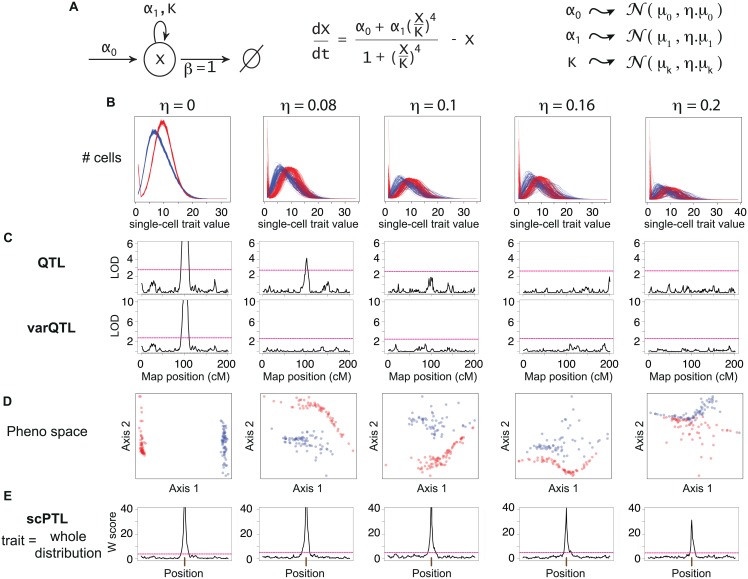
Test on simulations.A) A model of gene expression with positive feedback was used to simulate data (see methods). For each of ~130 distinct individuals, parameters α0, α1 and K were drawn from Gaussian distributions and then used to generate independent values of X in 10,000 cells of each individual. Mean values μ0, μ1 and μK depended on the genotype of individuals at a locus located in the middle of a 200cM genetic map. Other sources of inter-individual variability were modeled by the extrinsic noise strength η. B) Distributions obtained (one per individual) at various values of η. Color: genotype at the locus controlling μ0, μ1 and μK. C) QTL scans. For each individual, the mean (upper panels) or the variance (lower panels) of X were considered as quantitative traits and the map was scanned using interval mapping. Red dashed line: genome-wide significance threshold at 0.05. D) Coordinates of individuals (dots) in the phenotypic space obtained after computing Kantorovich distances and applying multi-dimensional scaling. Only the first two dimensions are shown. E) scPTL scan. At every marker position, linear discriminant analysis was performed. W score: -log10(Λ), where Λ is the Wilks' lambda statistics of discrimination (see methods). Red dashed line: empirical genome-wide significance threshold at 0.05 (see methods).